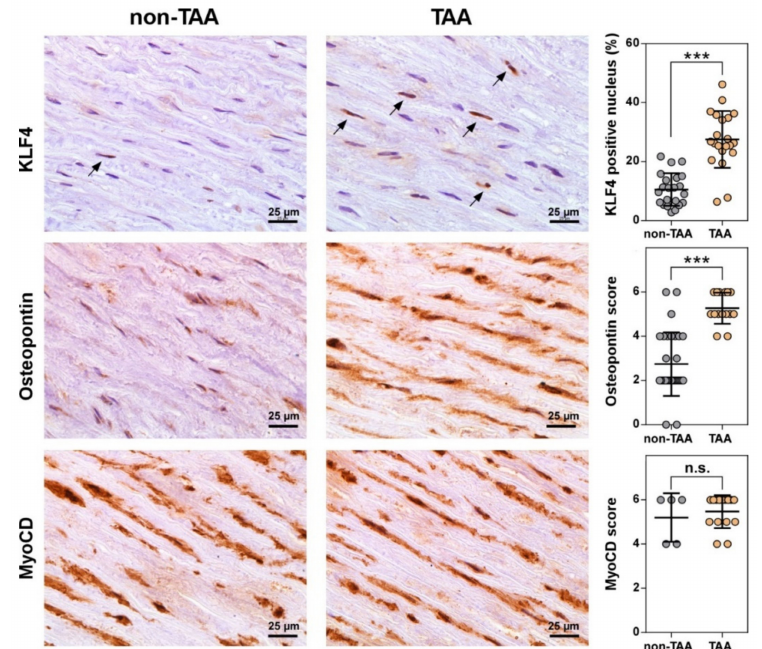
Figure 4. Immunohistochemical (IHC) analysis of KLF4, MyoCD, and osteopontin expression in non-TAA and TAA tissue samples. The abundance of proteins was examined by immunostaining and visualized with diaminobenzidine (brown). The sections were counterstained with hematoxylin (blue). Histological quantification of KLF4 was performed by counting KLF4 positive cell nucleus (black arrows; n = 43), whereas osteopontin ( n = 46) and MyoCD ( n = 20) by IHC score (graphs in right panel). Lines within boxes indicate KLF4 positive nucleus mean or MyoCD and osteopontin IHC score median values, whiskers – 5-95 percentile of KLF4 positive nucleus or MyoCD and osteopontin IHC score values. The histological data were assessed using Student’s t test (for KLF4) or non-parametric Mann-Whitney U test (for MyoCD and osteopontin). The significance between each group is shown as follows: n.s.—not significant; * p < 0.05; ** p < 0.01, *** p <